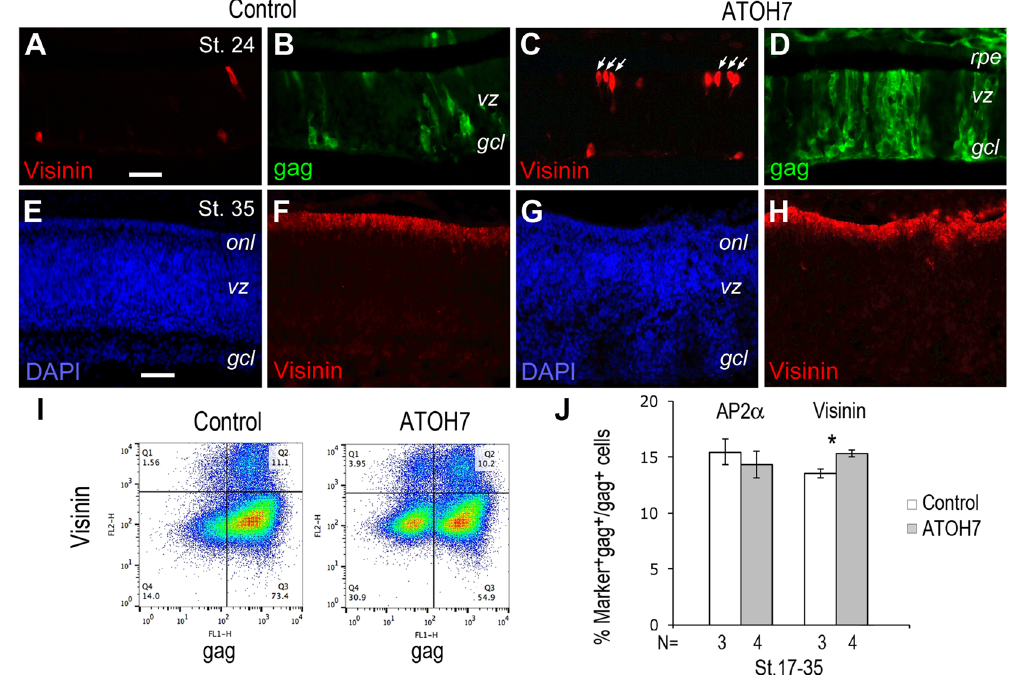
Figure 3. Effects of ATOH7 expression on cone photoreceptor cell production. ( A – H ) Immunocytochemistry of retinas infected with the control ( A , B , E , F ) or ATOH7 virus ( C , D , G , H ). Retina infected at stage 10 ( A – D ) or stage 17 ( E – H ) were labeled for visinin ( A , C , F , H ) and gag ( B , D ) at stage 24 or stage 35, respectively. Arrows in ( C ) point to visinin-positive cone cell precursors. Scale bars: A (for A – D ), E (for E – H ) 10 μ m. gcl , ganglion cell layer; onl , outer nuclear layer; rpe , retinal pigment epithelium; vz , ventricular zone. ( I , J ) Flow cytometry quantification of retinal cell markers. ( I ) Representative flow cytometry profiles of Visinin at stage 35 for retinas infected at stage 17. ( J ) Quantification of amacrine marker AP2 α and cone marker Visinin among gag-positive viral infected cells. Numbers of independent samples analyzed are indicated below the bars. Error bars indicate SEM. * p <